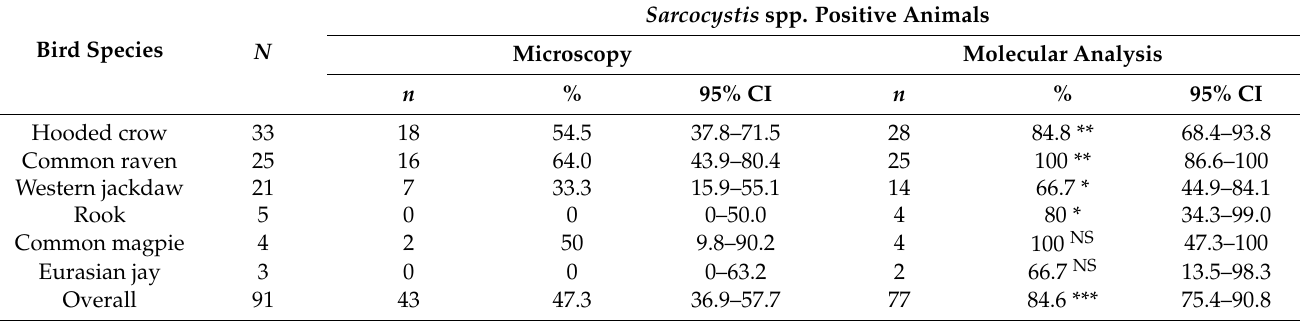
Table 2. Detection rates of Sarcocystis spp. established by microscopic and molecular analyses.